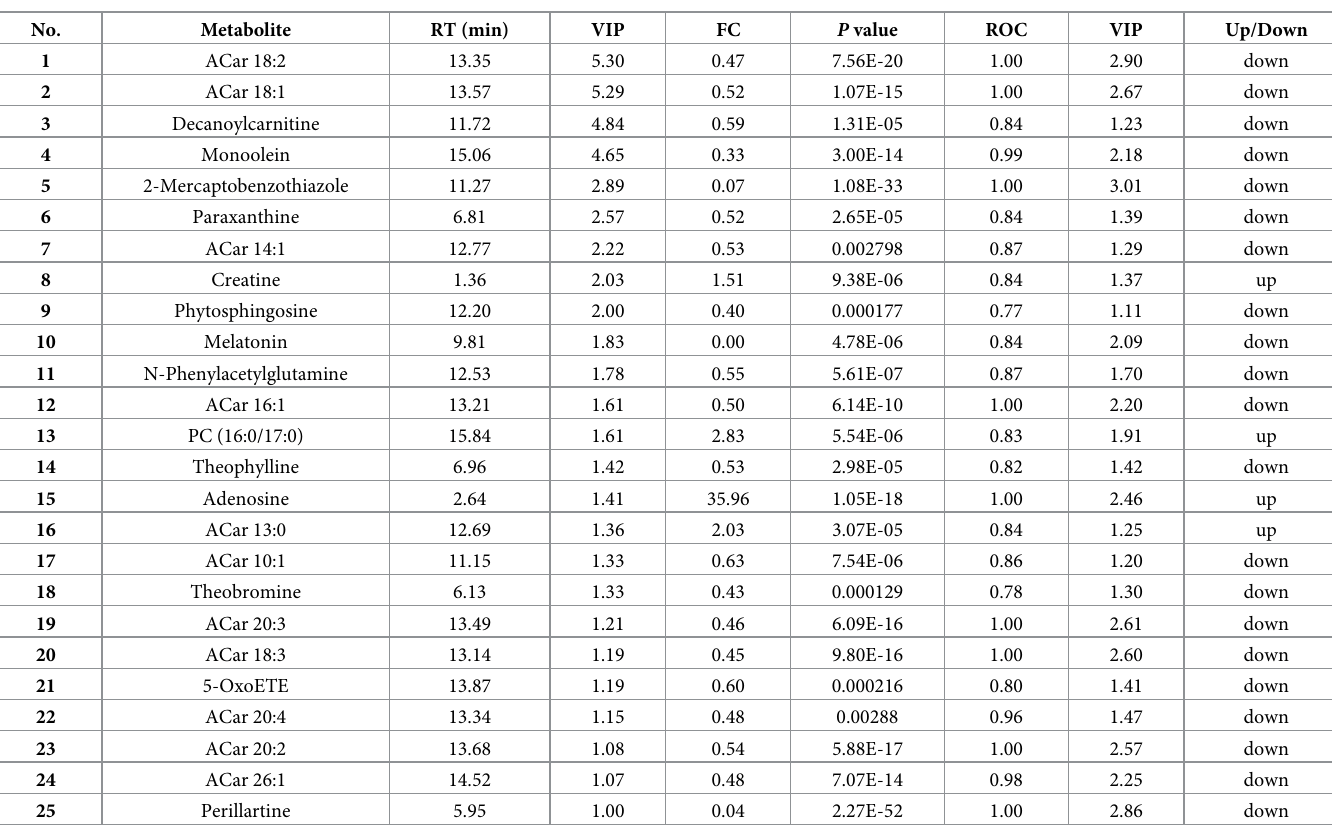
Table 4. The differential metabolites between HA and HAP.